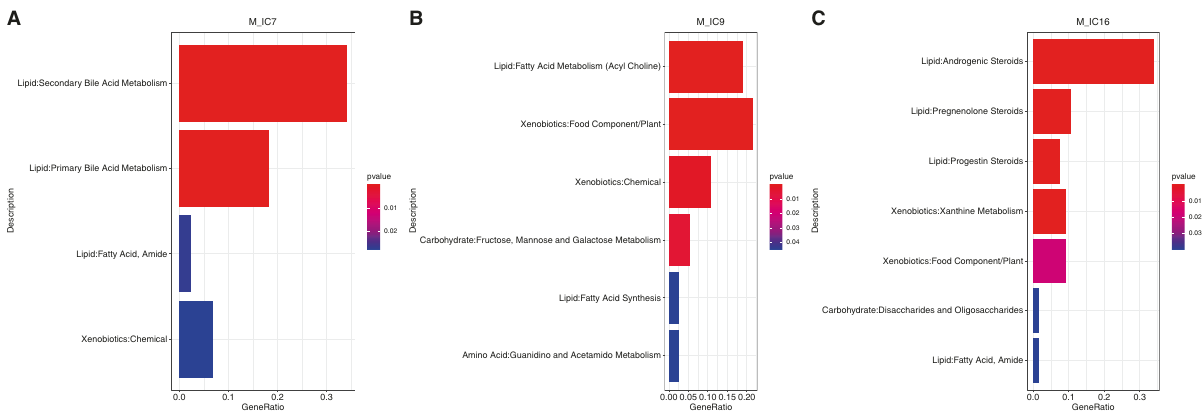
Fig. 2 Metabolic pathway analyses. In each plot, the length of the bar corresponds to the ratio of the number of metabolites in the pathway to the number of metabolites in the module, whereas the color corresponds to the p-value gradient. The bars are ordered by p -values. A Bar plot showing the list of signi fi cant pathways for the M_IC7 module. B Bar plot showing the list of signi fi cant pathways for the M_IC9 module. C Bar plot showing the list of signi fi cant pathways for the M_IC16